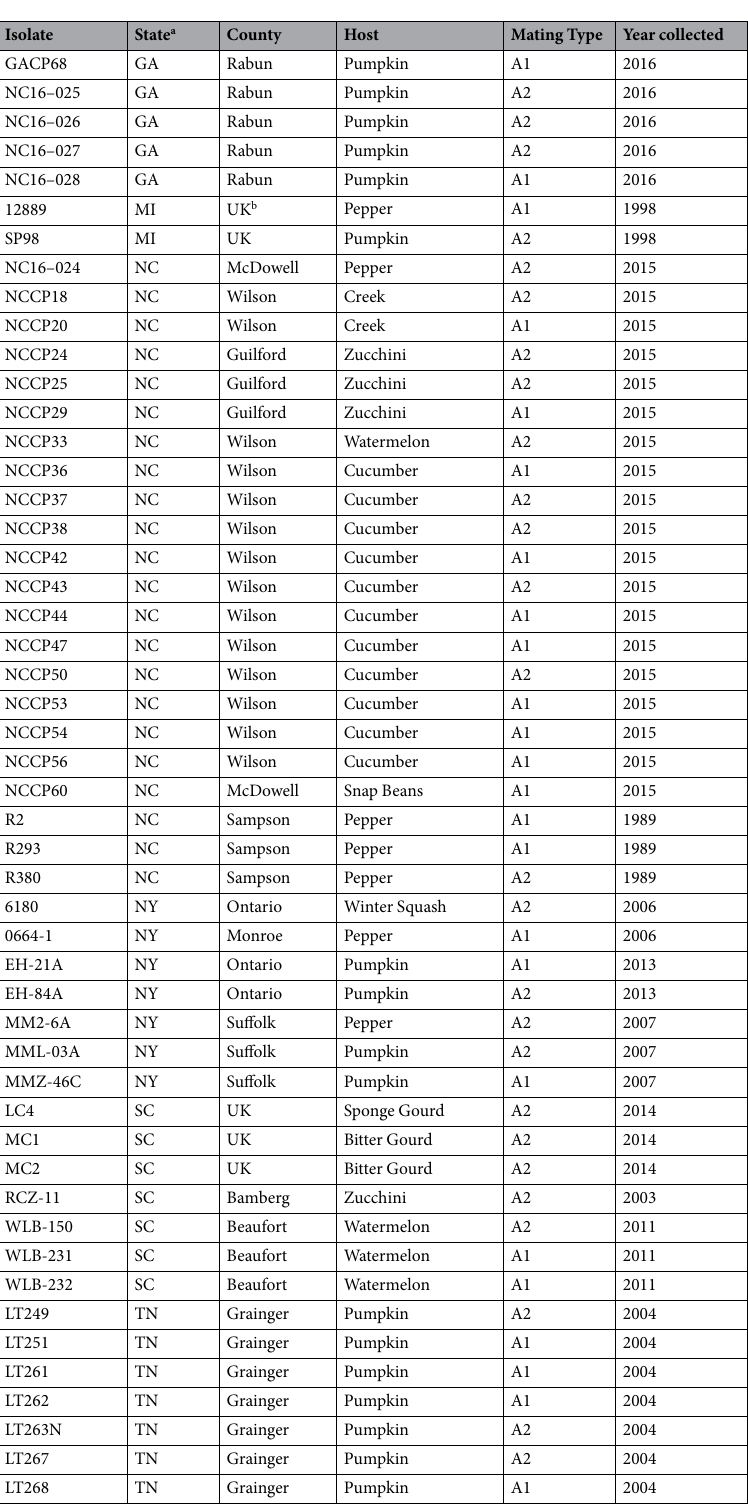
Table 1. 50 Phytophthora c apsici isolates used for microsatellite evaluation via fragment analysis. a States: NC: North Carolina, SC: South Carolina, TN: Tennessee, NY: New York, MI: Michigan, and GA: Georgia. Isolates were obtained from collaborators Dr. C. Smart, Dr. S. Kousik, Dr. M. Hausbeck, Dr. K. Lamour, and Dr. J. Ristaino. b Unknown county of